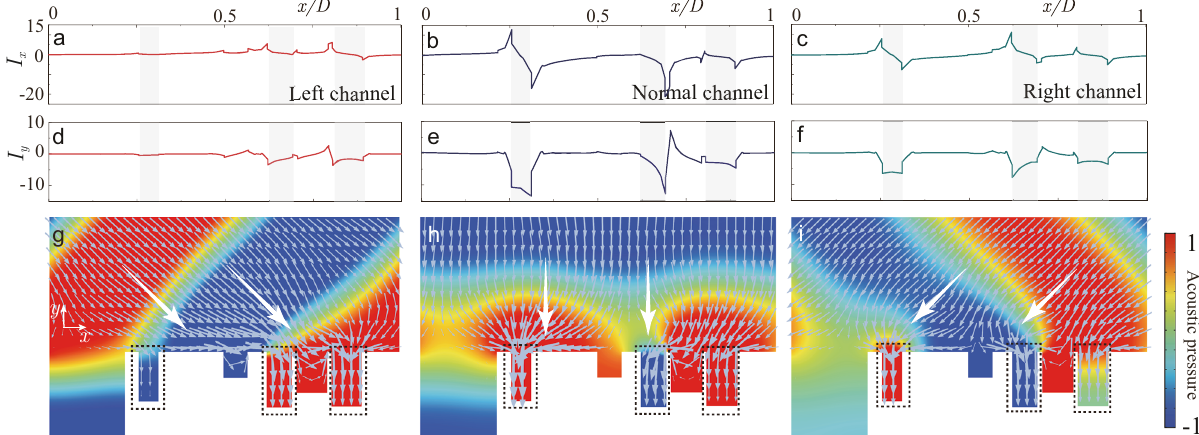
Fig. 6 Non-local intensity fl ow distribution. The x -components of the sound intensity (normalized by the incident fi eld) along the metagrating surface under left ( a ), normal ( b ) and right ( c ) incidences. D is the period of the metagrating. The regions in gray identify the locations of lossy grooves. d – f The y - components of the sound intensity along the metagrating surface. The sound fi eld distributions near the surface of the metagrating under left ( g ), normal ( h ) and right ( i ) incidences, where the color maps illustrate the acoustic pressure distributions and the gray arrows represent the energy fl ow. Areas bounded by dotted lines represent the lossy grooves. The white large arrows indicate the direction of